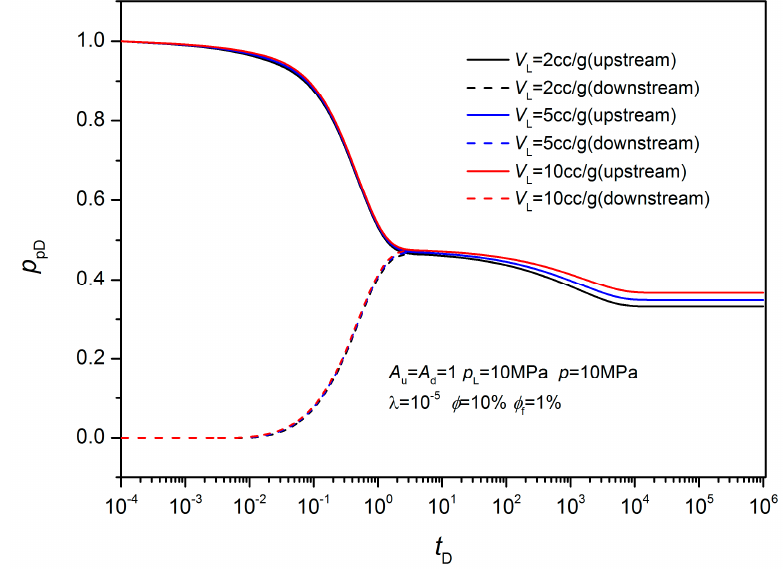
Figure 9. The influence of the Langmuir pressure on the pseudo-pressure curves of the non-equilibrium sorption model.